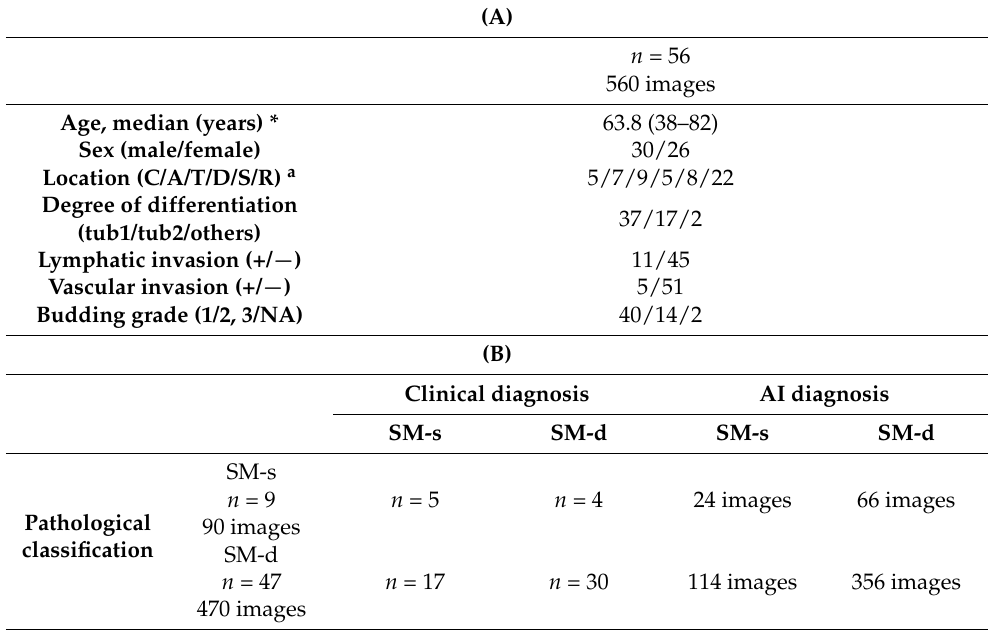
Table 4. Prospective test set. (A) Results of CNN learning. (B) Diagnostic accuracy: Clinical diagnosis vs. AI